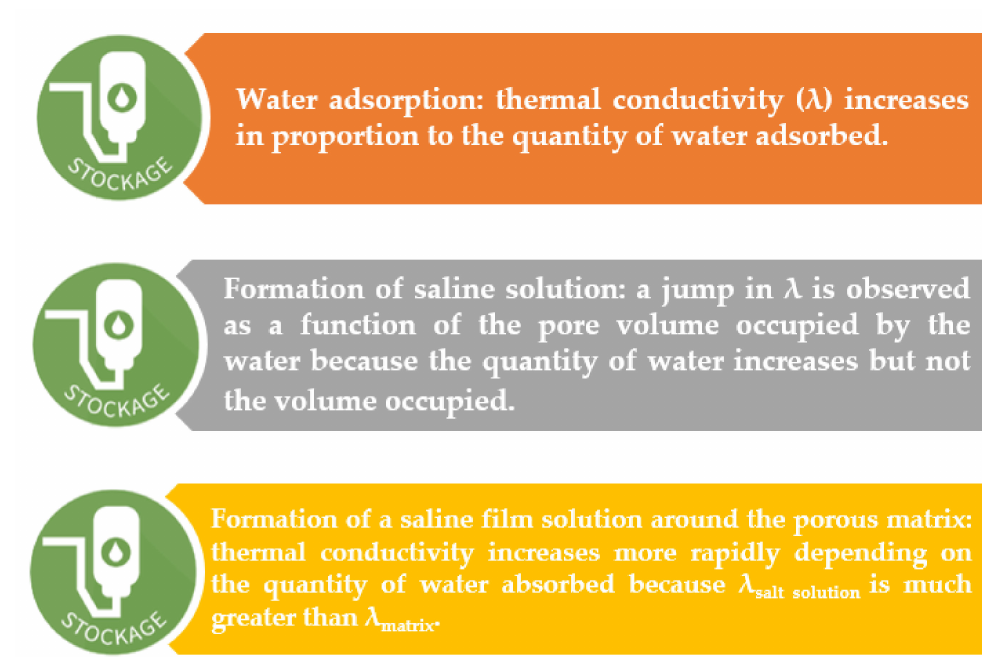
Figure 8. Phase evolution of the thermal conductivity of the composite